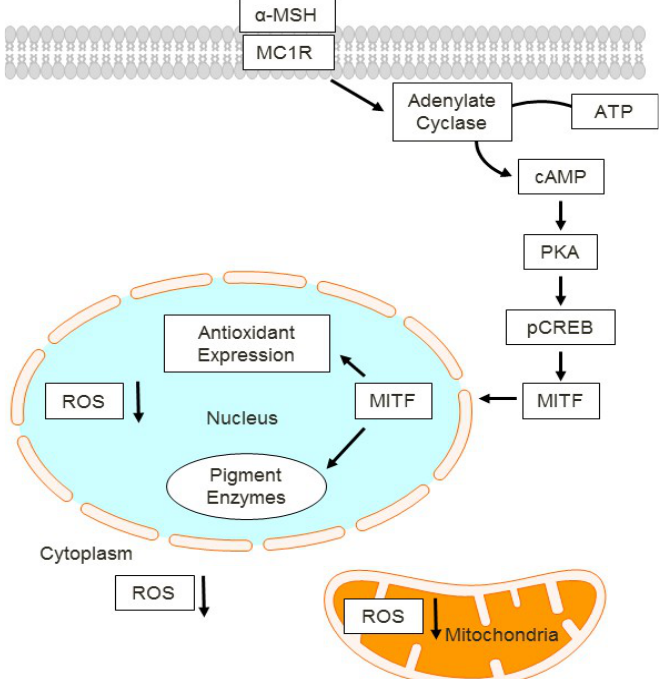
Figure 2. MC1R signaling cascade in melanocytes. Activated by its agonist alpha-MSH, MC1R promotes cAMP second messenger generation which induces melanocyte differentiation and survival pathways involving PKA, CREB and Mitf. In this way, cAMP induces both melanin production and antioxidants that reduce cellular ROS. cAMP, cyclic adenosine monophosphate. PKA, protein kinase A. pCREB, phosphorylated cAMP response binding element. ROS, reactive oxygen species. MITF, microphthalmia (Mitf) transcription